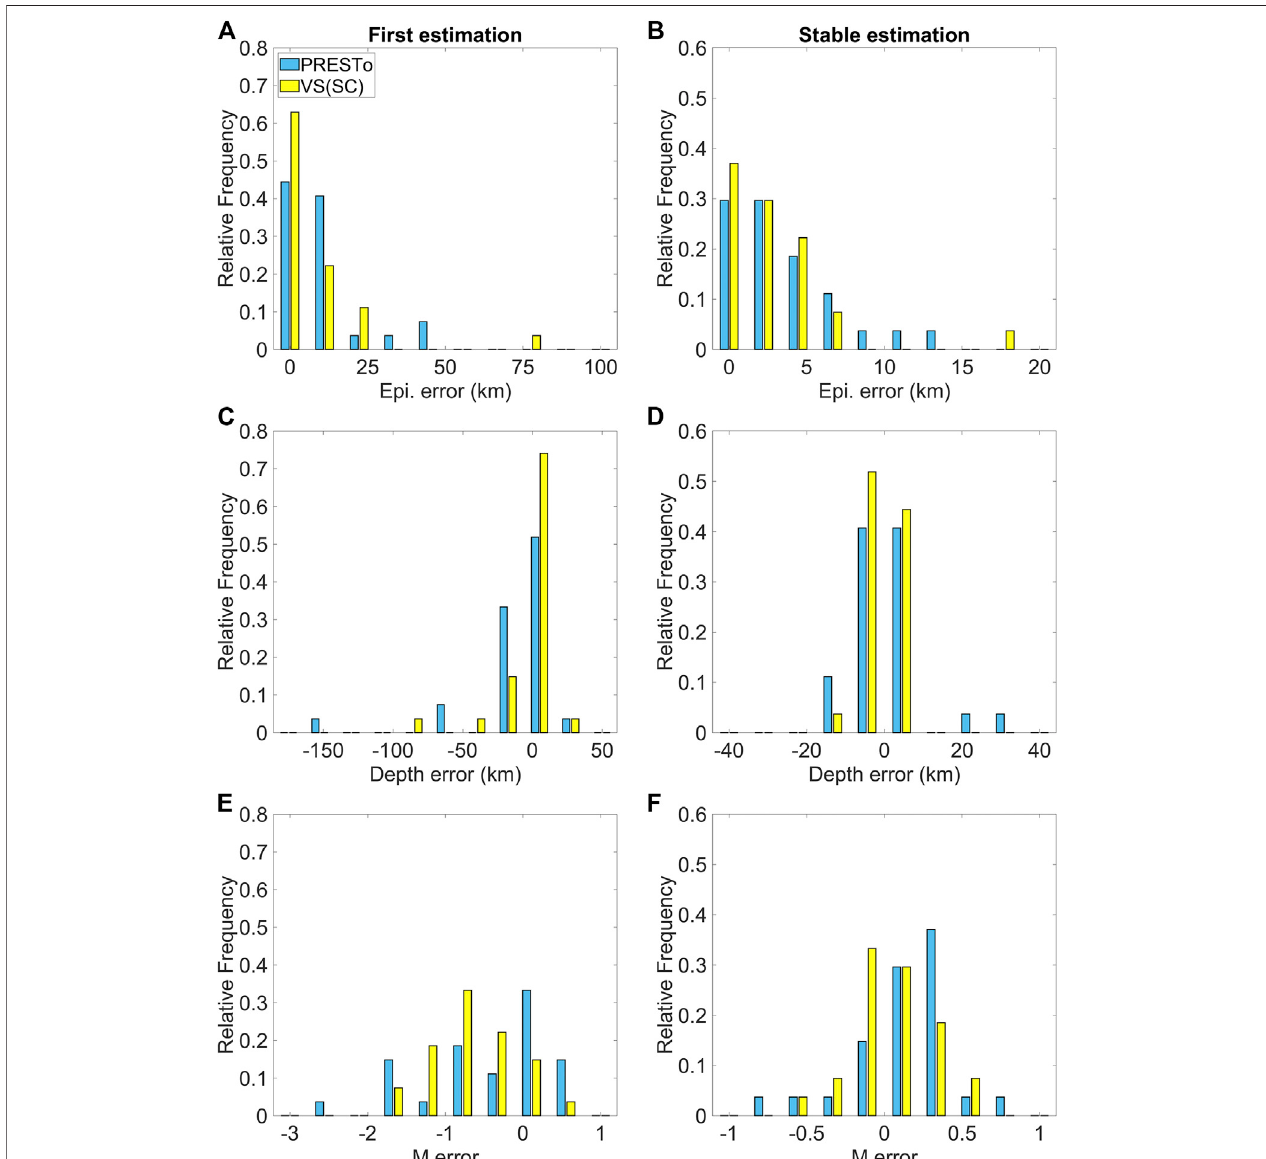
FIGURE6| ComparisonbetweenthePRESToandVS(SC)algorithmsintermsof (A,B) epicentre; (C,D) depth;and (E,F) magnitude(M)accuracy.Eachhistogram contains results for all 27 considered events. The left column provides errors associated with fi rst estimates. The right column provides errors associated with stable estimates. Magnitude and depth errors are computed by subtracting the bulletin values from the corresponding estimates of the algorithms, while epicentral errors represent the distance between the bulletin and estimated epicentre locations.